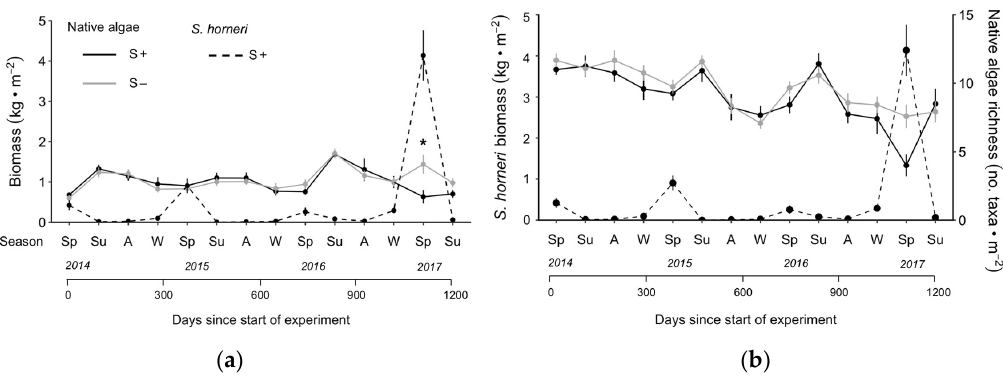
Figure 2. Mean (± SE) biomass ( a ) and taxonomic richness ( b ) of native algae in Sargassum horneri - removal (S − ; grey solid line) and non-removal (S+; black solid line) plots, overlaid by biomass of S. horneri in non-removal plots (S+; dashed line). Asterisk indicates sampling period where multiple comparisons tests (Tukey’s HSD, p < 0.05) indicated a significant difference between treatments. N = 12 plots per sampling period. First data points in each series are from the pre-removal census. Table 1. Results from likelihood ratio tests and model selection for determining the influence of experimental removal of Sargassum horneri on the (a) biomass and (b) taxonomic richness of native algae. Independent variables included were: Days since the start of the experiment (Days), S. horneri removal treatment (Removal), and season of the sampling period (Season). Individual variables were tested against the null model and interactions were tested against additive models with the same